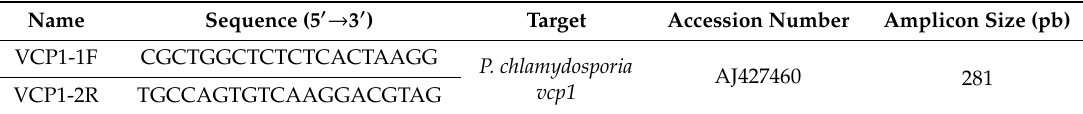
Table 1. Primers used to detect / quantify the fungus Pochonia chlamydosporia in banana plant roots.